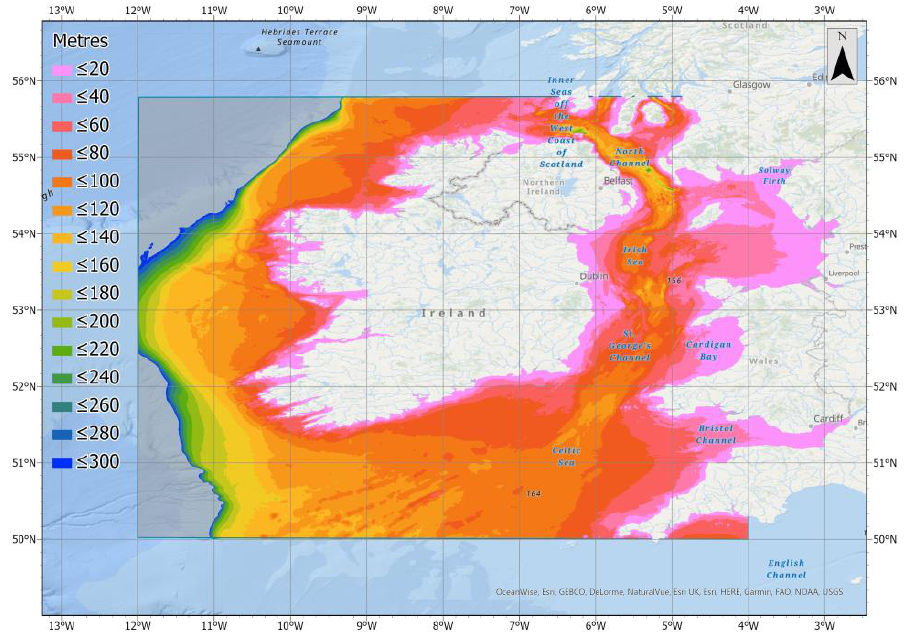
Figure 14. The water depth between 0 and 300 m (values exceeding 300 m are shaded grey).